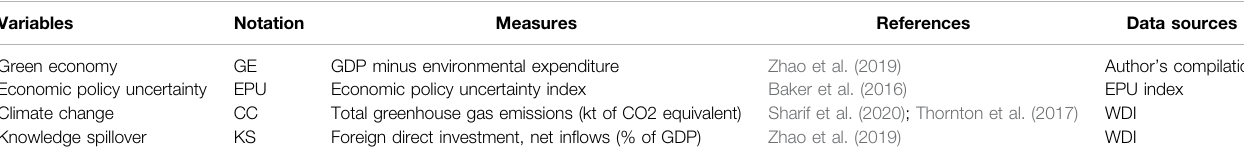
TABLE 1 | Variable notation and proxy.